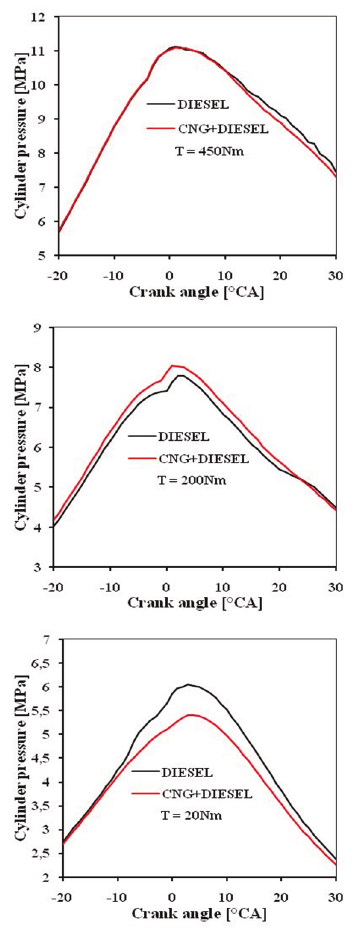
Fig. 6. Comparison of the pressure waveforms during the combustion process in the Perkins 1104D-E44TA engine cylinder running according to the load characteristics for crankshaft speed n = 1800 rpm, with selected loads of the engine T = 20, 200 and 450 Nm, in dual-fuel CNG + Diesel operation and powered by diesel fuel only